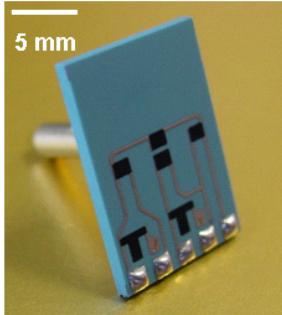
Figure 3. The piezoresistive ceramic pressure sensor.